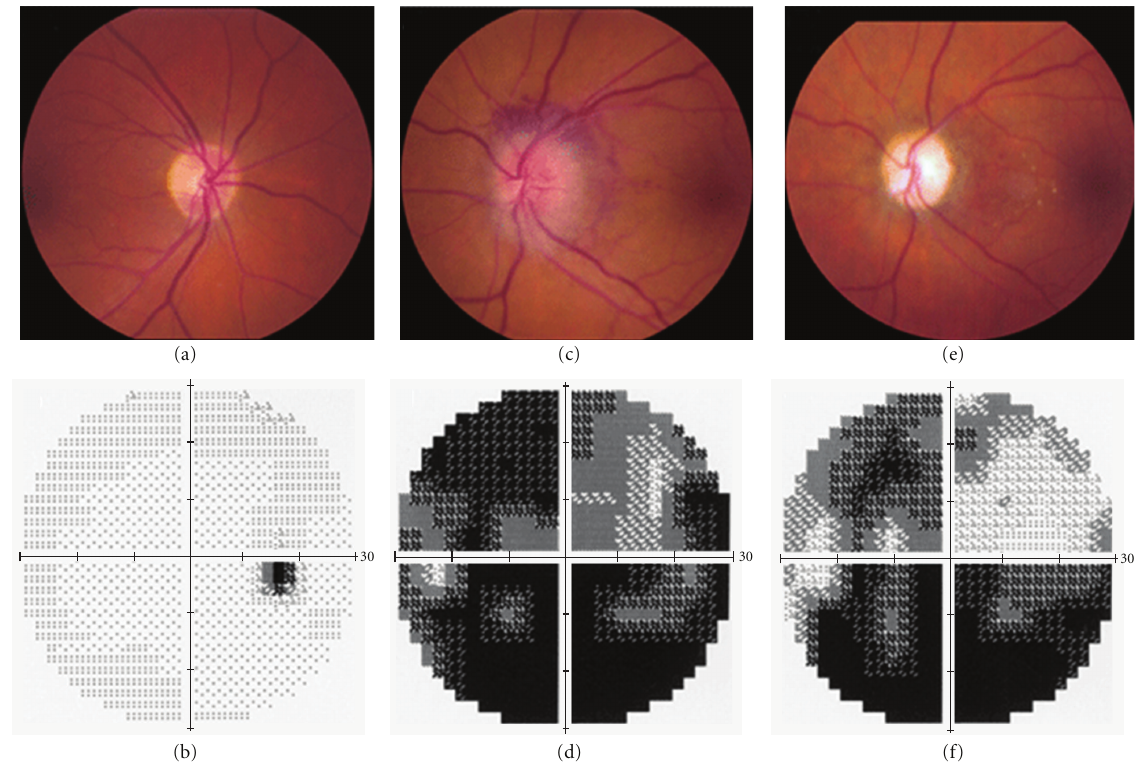
Figure 1: Nonarteritic anterior ischemic optic neuropathy (NAION) in the left eye of a 53-year-old man patient with a history of hypercholesterolemia. The right optic disk is pink and flat (a). Automated perimetry, using the Humphrey visual field 24-2 protocol, shows a normal visual field (b), with the dark spot in the temporal field being the physiologic blind spot. Acutely, the left optic disk appears swollen and hyperemic, with hemorrhage at the superior and temporal disk margin (c). Automated perimetry shows di ff use visual-field loss, more marked in the inferior aspect of the field (d). On review at 6 months, the optic disk swelling has resolved and the disk appears di ff usely pale and atrophic (e). Automated perimetry shows improvement in the superior visual field, with a persistent inferior altitudinal defect